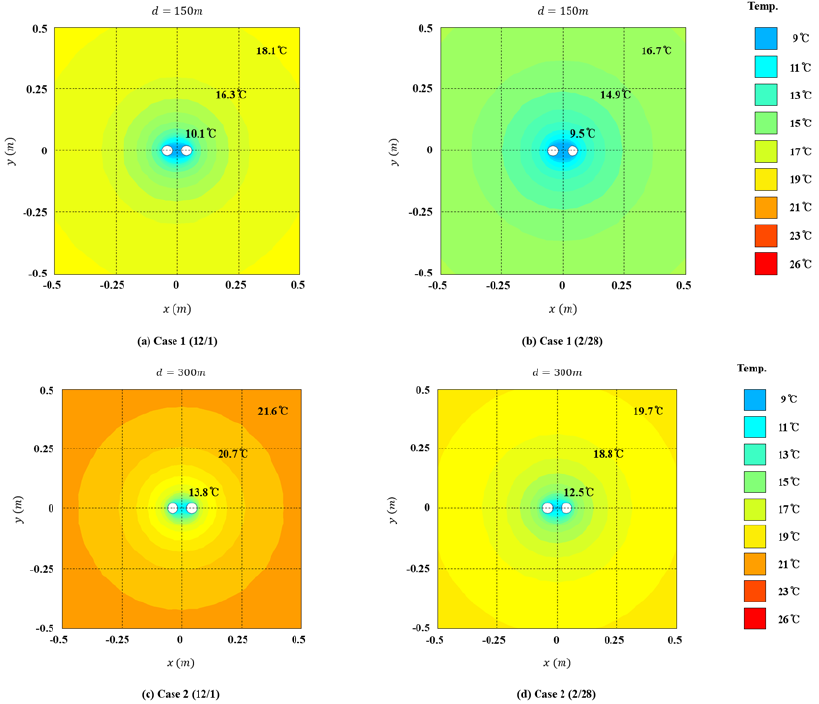
Figure 6. Distribution of underground temperature: Case 1 ( GHX : 150 m); and Case 2 ( GHX : 300 m).